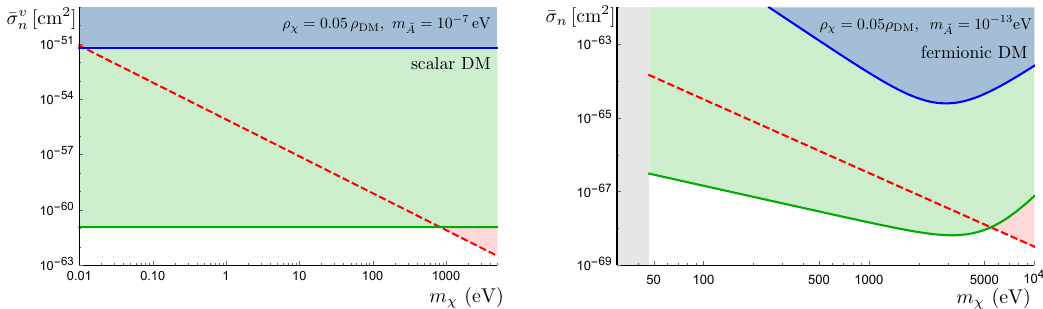
Figure 8 . Expected constraints on DM-neutron cross-sections for DM masses corresponding to the particle regime. Both panels show cases ρ χ = 0 . 05 ρ DM and g χ = 1. Left panel: scalar case with = 10 − 7 eV. Same colour code as in figure 7. Right panel: fermionic DM mediator mass m ˜ A